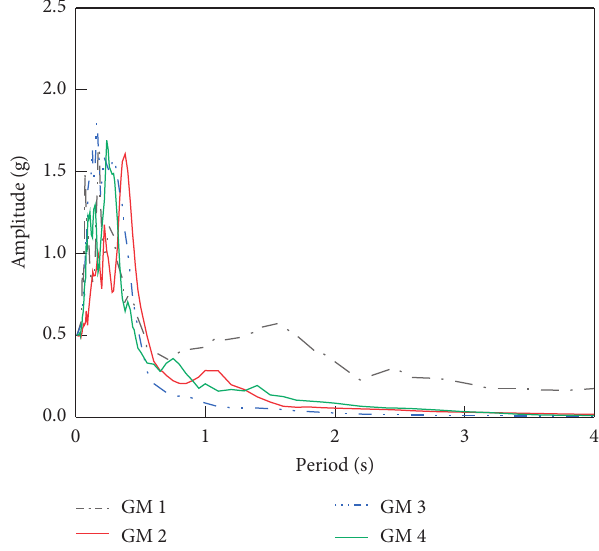
Figure 15: Scaled acceleration spectra for the selected ground motions with different